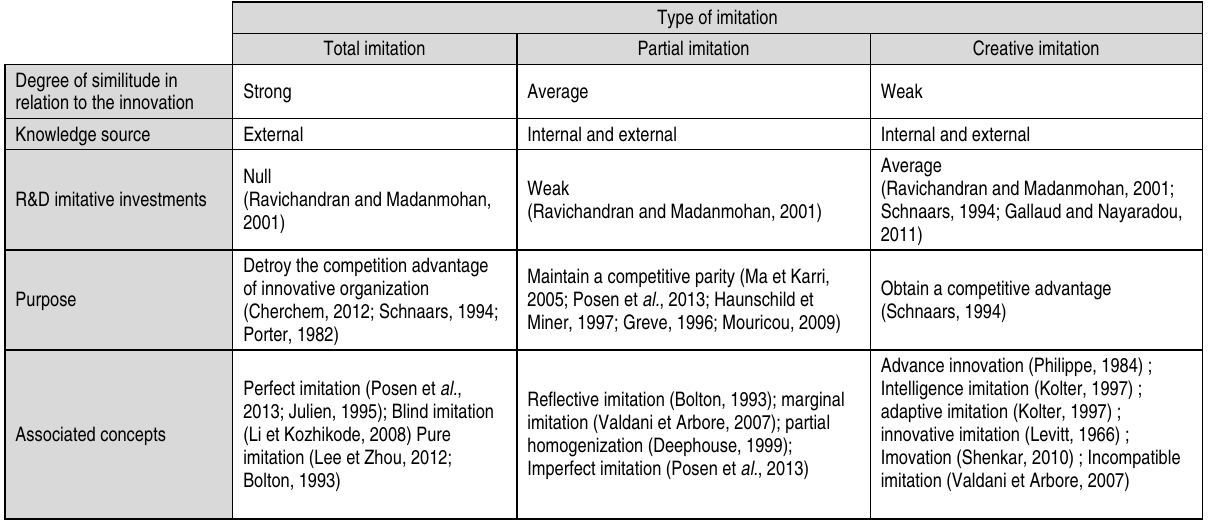
Table 3. The characteristics and the concepts associating to other types of